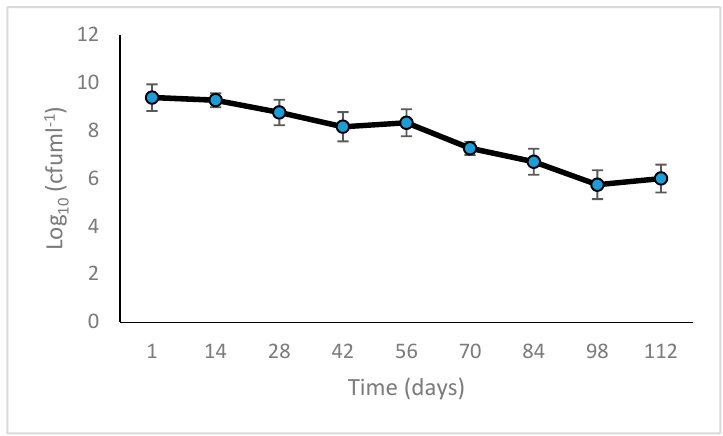
Figure 1. Cell numbers of Escherichia coli during the amendment with PtCl 4 over 112 days. The results represent the mean of triplicate values with standard deviations.